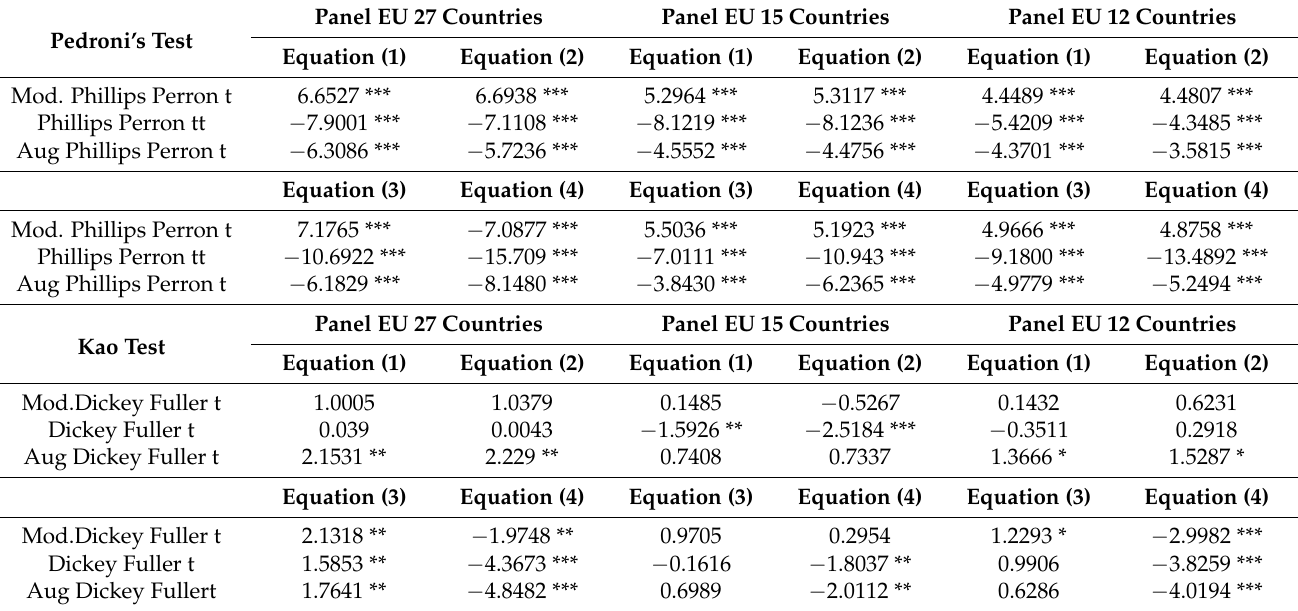
Table 4. Pedroni’s and Kao cointegration test